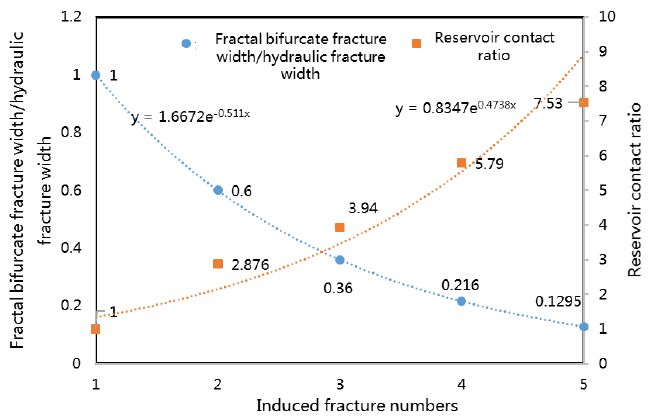
Figure 6. Fractal fracture width and reservoir contact area change with respect to induced fracture